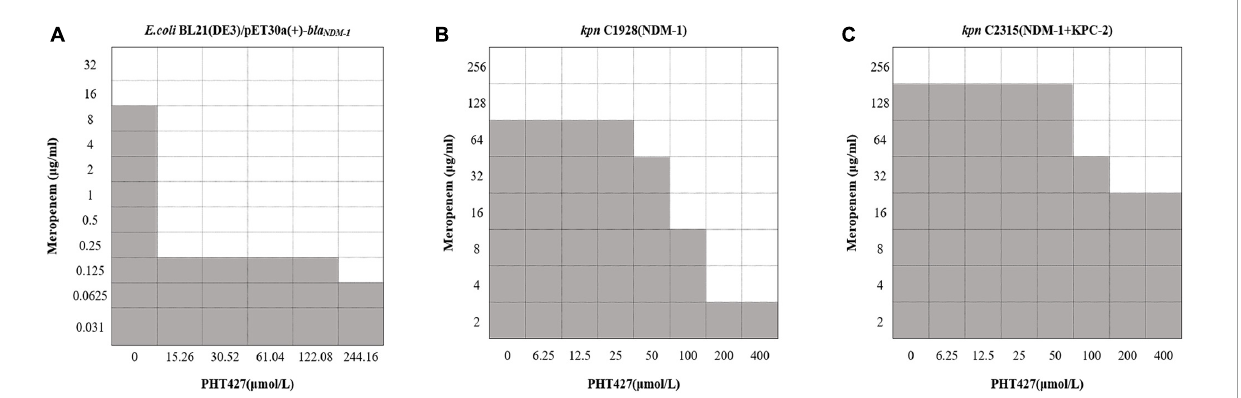
FIGURE6 PHT427 restored the susceptibility of meropenem against E. coli BL21(DE3)/pET30a(+)- bla NDM − 1 , Klebsiella pneumoniae clinical strains C1928 (producing NDM-1) and C2315 (producing NDM-1 and KPC-2). Checkerboard microdilution assays for PHT427 in conjunction with meropenem against. (A) E.coli BL21(DE3)/pET30a(+)- bla NDM − 1 . (B) Klebsiella pneumoniae clinical strain C1928 (producing NDM-1). (C) Klebsiella pneumoniae clinical strain C2315 (producing NDM-1 and